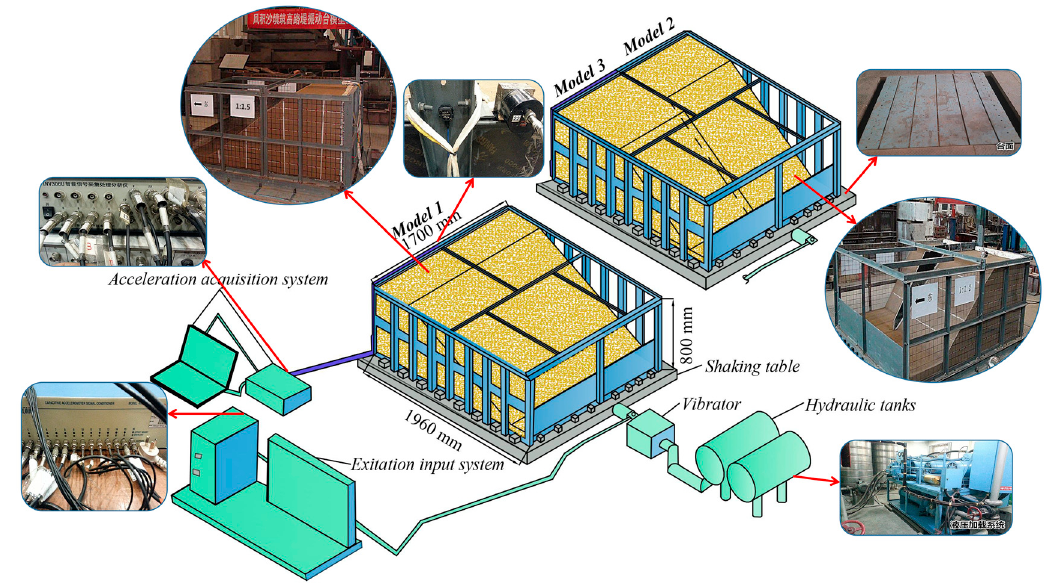
Figure 4. Experimental setup design.